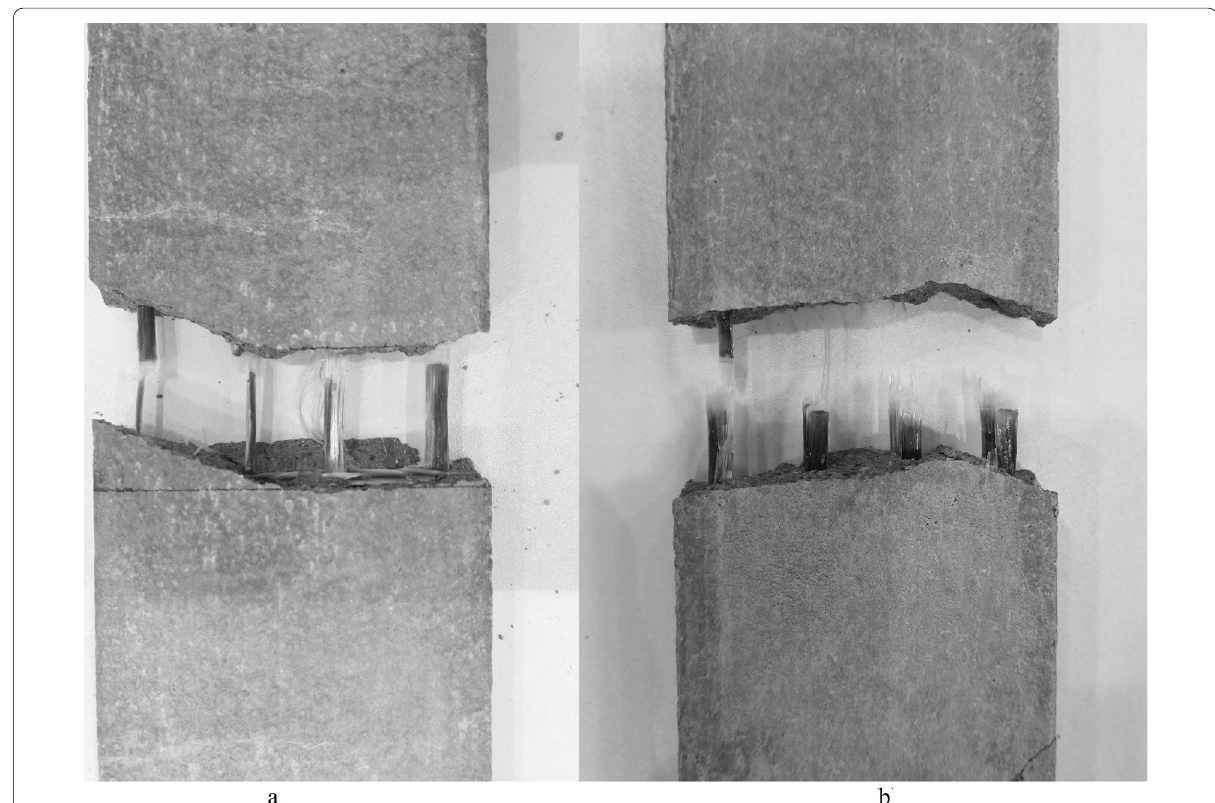
Fig. 8 The failure mode of tensile bond tests: a failure mode of Group B specimens; b failure mode of Group C